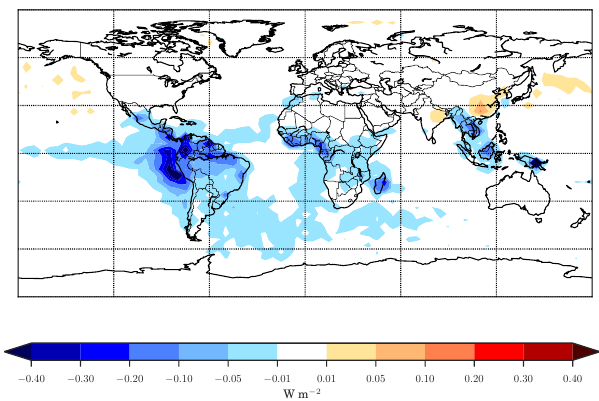
Figure 8. The cloud-albedo aerosol indirect effect difference be- tween